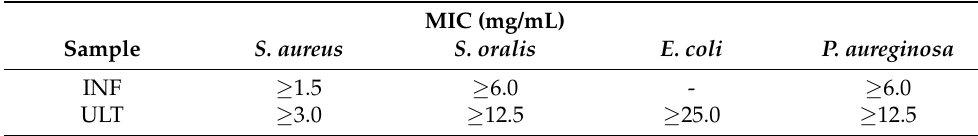
Table 2. Minimum inhibitory concentration values obtained by microdilution in a 96-well microplate for infusion (INF) and ultrasound (ULT) rosemary extracts with an initial concentration of 50 mg/mL to 0.02 mg/mL.